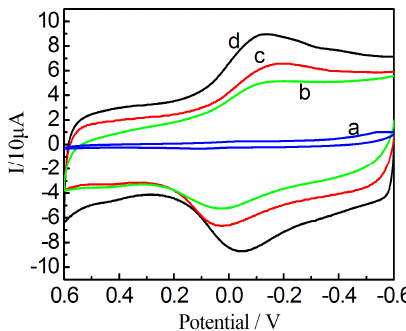
Figure 2. CVs of RIF on the different electrodes: Bare GCE (a); CeO 2 nanorods/GCE (b); MWCNTs/GCE (c); MWCNTs-CeO 2 nanorods/GCE (d) in 0.1 M phosphate buffffer solutions (PBS) (pH = 7.0). Scan rate: 0.10 V/s; the concentration of RIF: 1 × 10 − 6 mol/L.